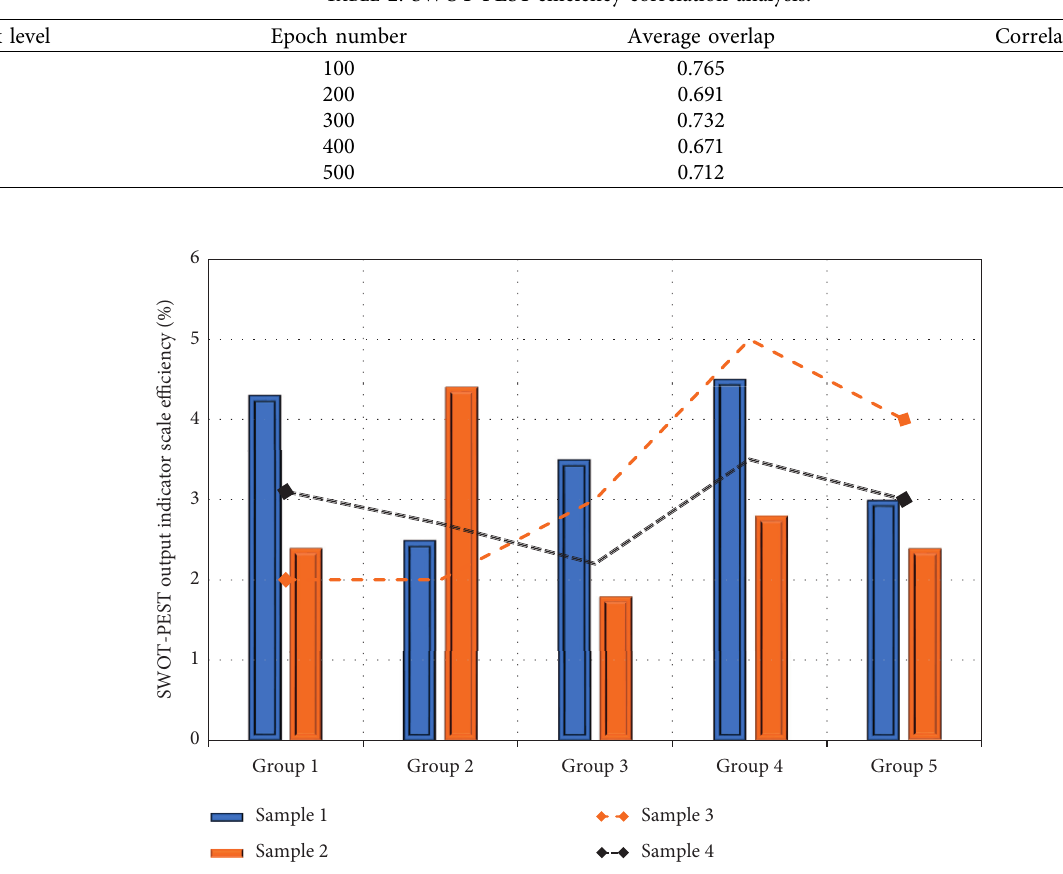
Figure 7: SWOT-PEST output indicator scale efficiency